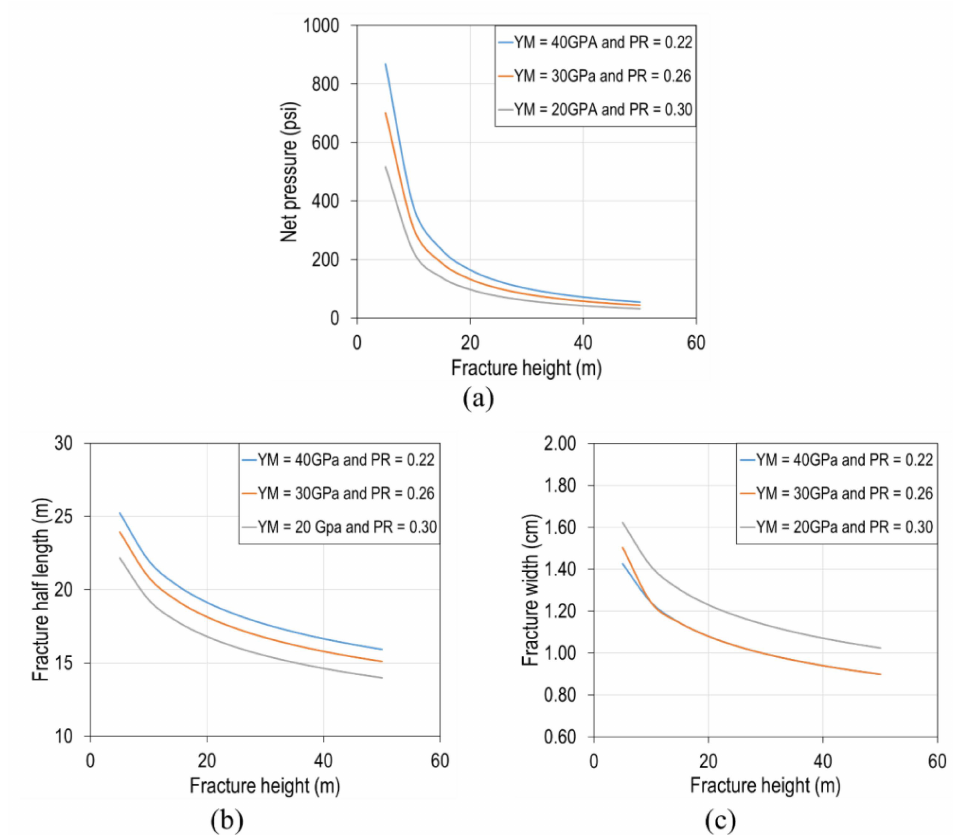
Figure 23. Calculated ( a ) net pressure, ( b ) fracture half-length, and ( c ) fracture width for different fracture heights, Young’s modulus, and Poisson’s ratio